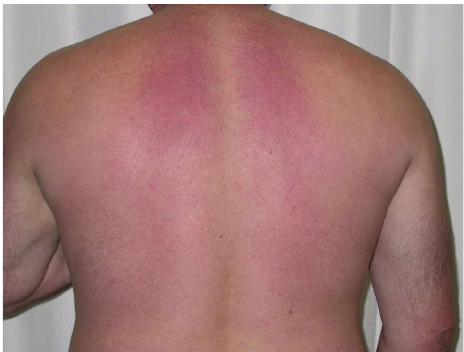
Figure 1: Thickening and erythema of the upper part of the back. mellitus and good metabolic control recently observed in our hospital.